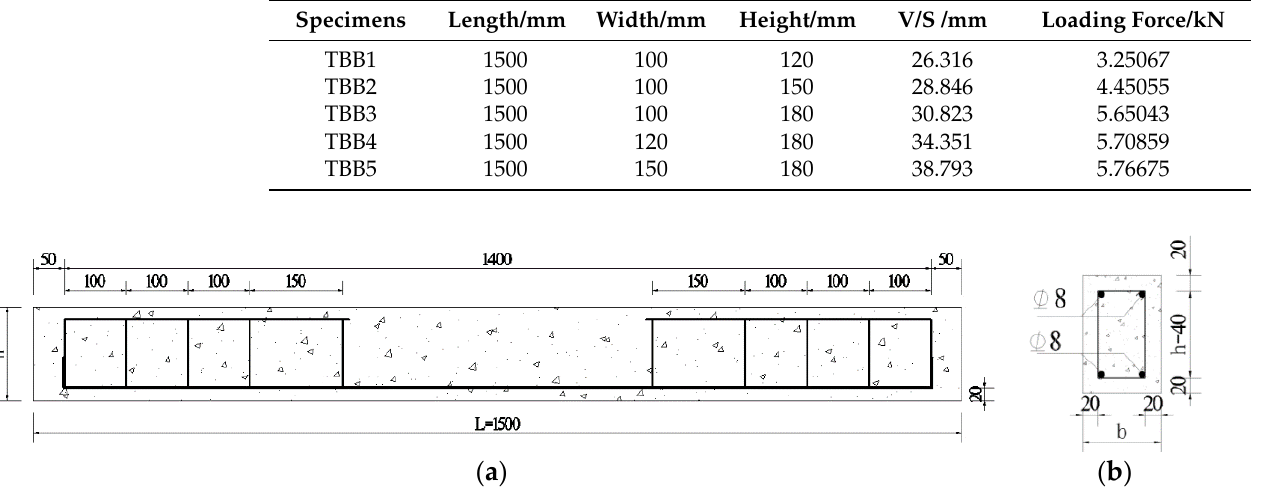
Figure 1. Structure of ceramsite concrete beam (Unit: mm). ( a ) Elevation. ( b ) Cross section.